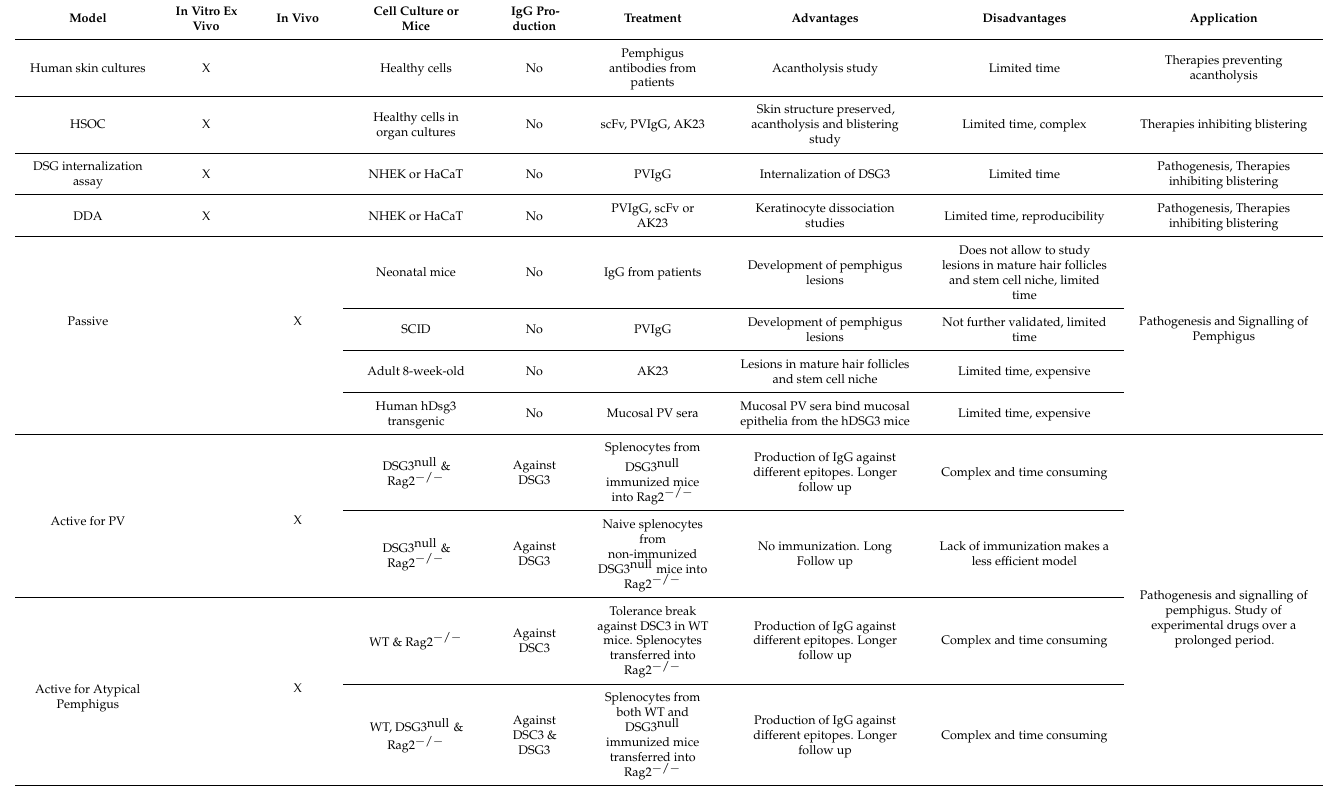
Table 1. Schematic summary of the models currently available to study